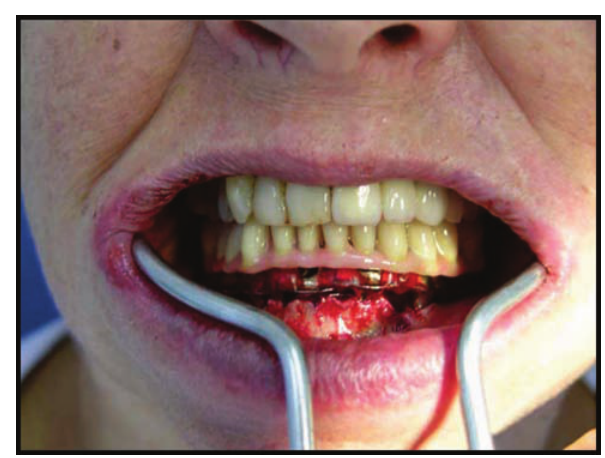
FIGURE 9 – Test of teeth on the infra-structure